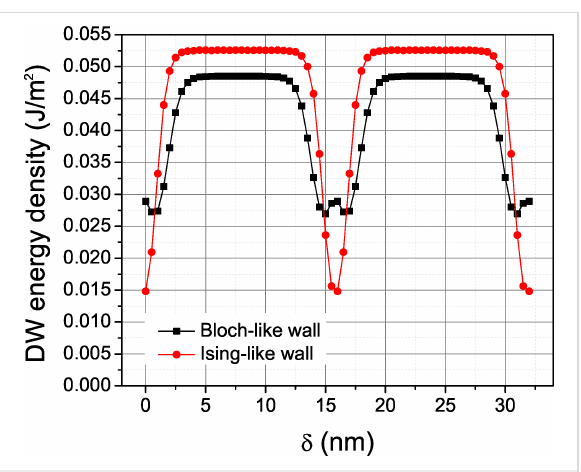
Figure 7: Landau part of the domain wall energy density as a function of the position of the ferroelectric domain wall, estimated by sliding a rigid polarization profile across the potential relief of the superlattice described in the